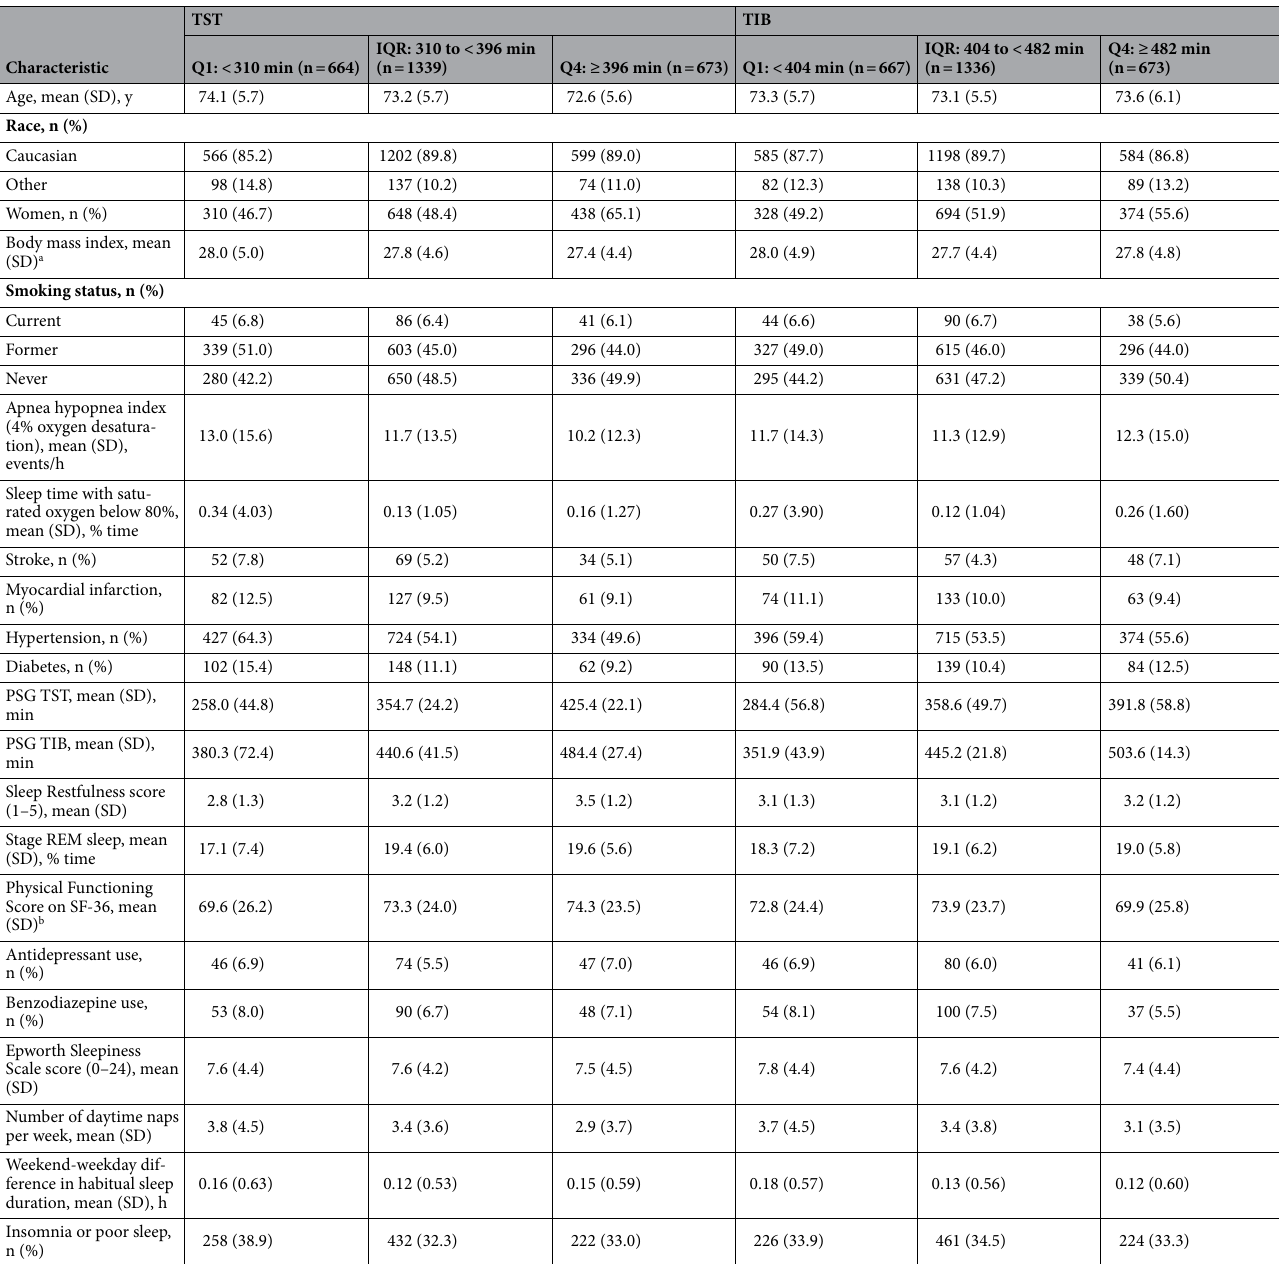
Table 2. Baseline demographic, health, and sleep characteristics of older adults by TST quartile or TIB quartile (n = 2676). SD standard deviation, PSG polysomnography, TST total sleep time, TIB time in bed, REM rapid eye movement. a Body mass index is calculated as weight in kilograms divided by height in meters squared. b SF-36, Short Form 36 Health